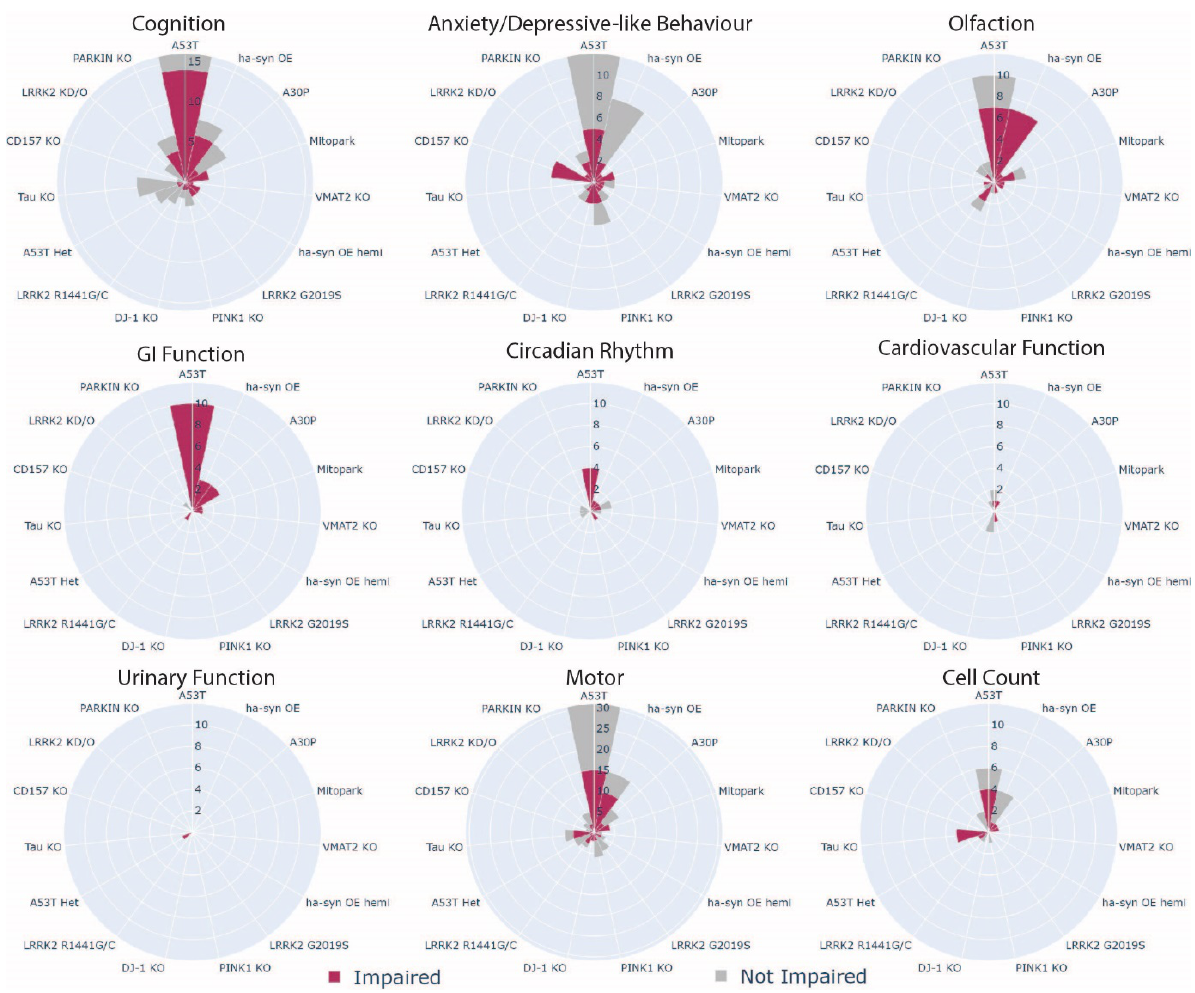
Figure 6. Wind rose charts of the incidence of MDS criteria, motor, and cell count phenotypes across PD rodent models. Radial axis is the number of studies. Numbers in red is a significant impairment of the phenotype, grey is no change or an improvement of the phenotype. The overall wedge height of the bar (red + grey) is the total number of studies for the animal model. Note max radial axis of ‘Motor’ is 31, ‘Cognition’ is 16, and the remaining are set at 12.